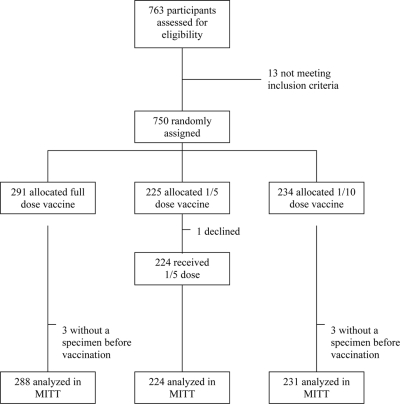
Consort flowchart.